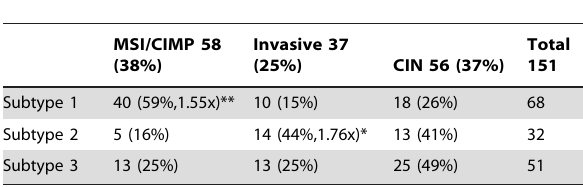
Table 1. Overlap between our subtypes and TCGA